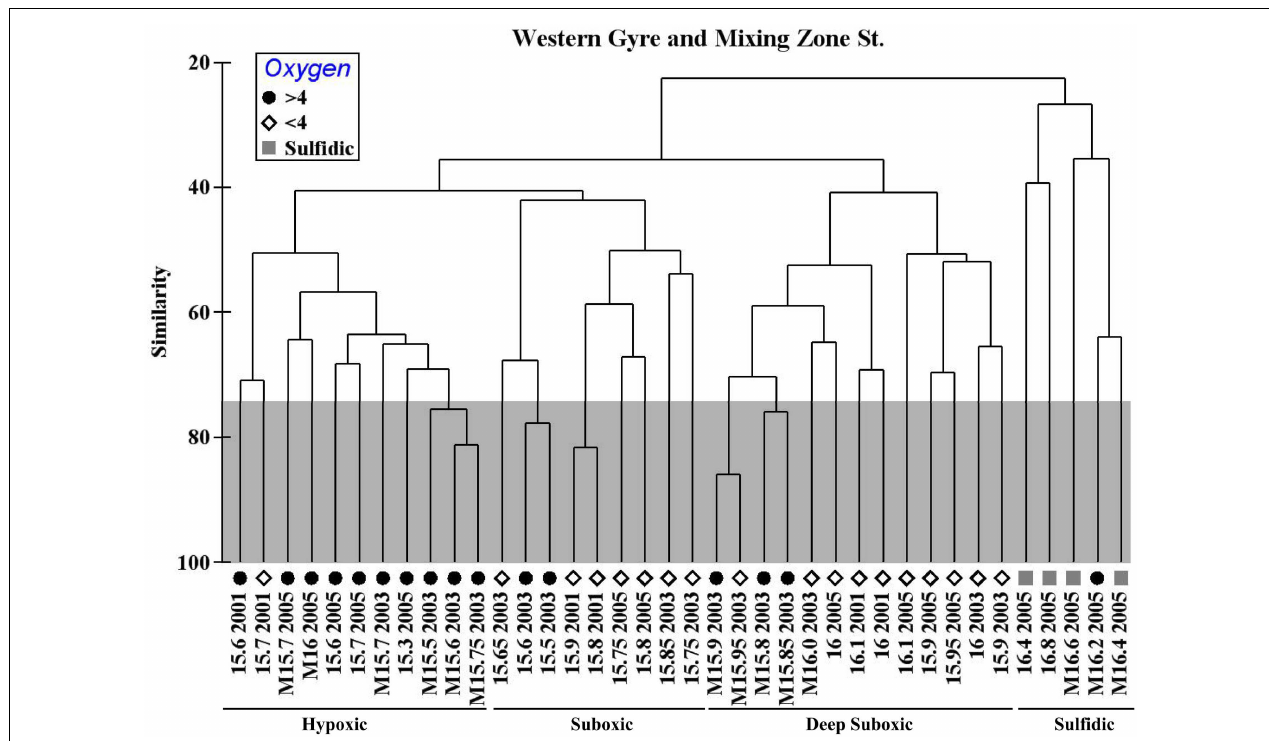
Symbols indicate oxygen concentrations: > 4 µ M O 2 (circle), < 4 µ M O 2 (diamond), sulfidic (square). Error was determined using a Monte Carlo simulation; nodes within the gray box are not significantly different (e.g., σ θ = 15.5–15.75 from the 2003 mixing zone